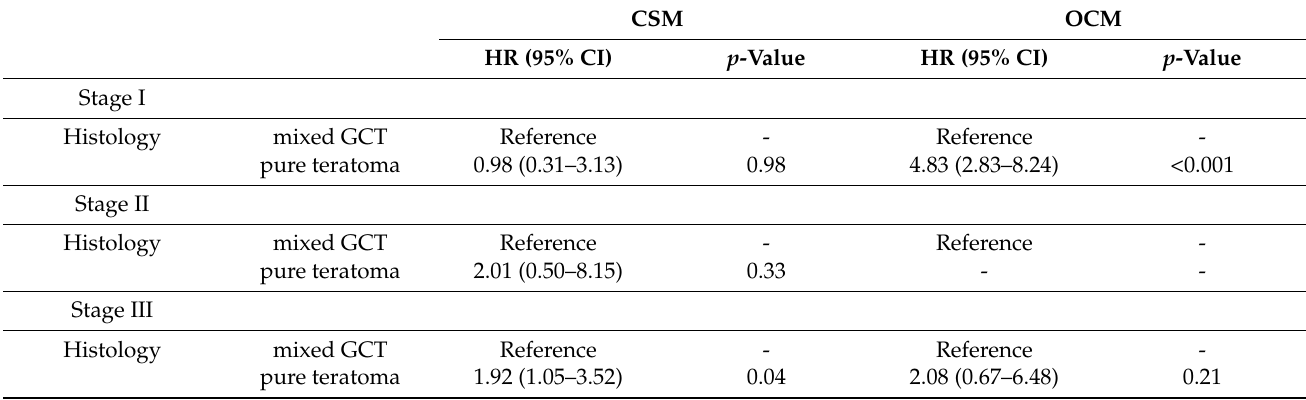
Table 2. Multivariable competing-risk regression models predicting cancer-specific mortality (CSM) and other-cause mortality (OCM) in patients with pure teratoma or mixed germ cell tumor (GCT) stages I, II (adjusted for age at diagnosis, retroperitoneal lymph node dissection) and stage III (adjusted for age at diagnosis, retroperitoneal lymph node dissection, International Germ Cell Cancer Collaborative Group risk group, presence of lung metastases). CSM OCM HR (95% CI) p -Value HR (95% CI) p